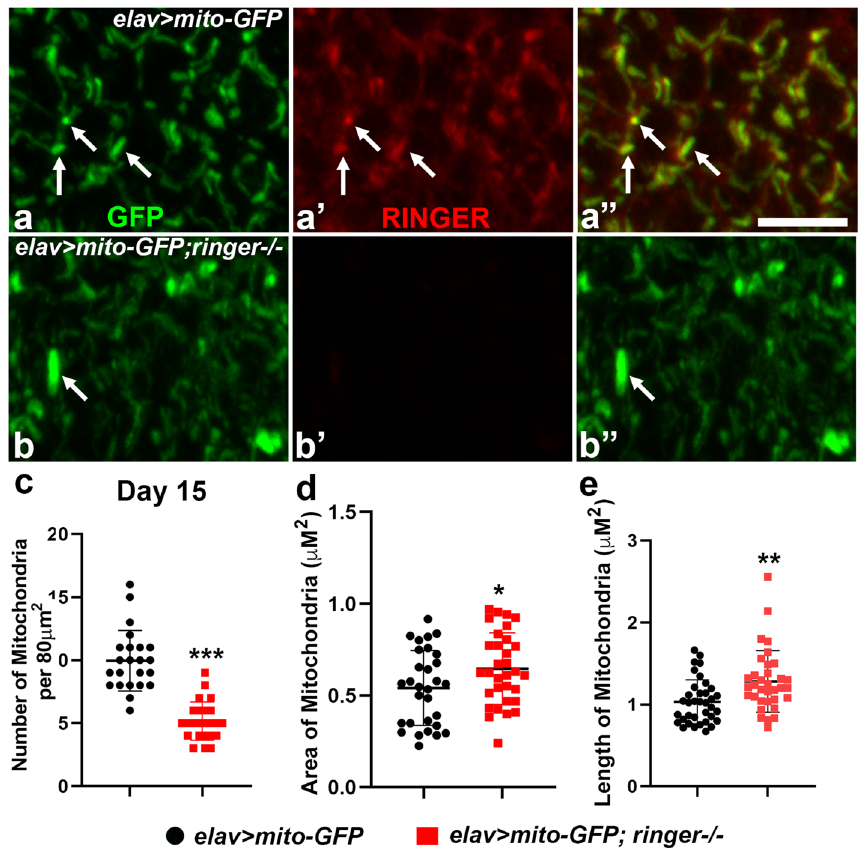
Figure 4. Ringer localizes to mitochondria and loss of Ringer leads to mitochondrial enlargement. ( a - b” ) Confocal images of day 15 adult brains stained with with anti-GFP (green), ( a , a” and b , b” ) and anti-Ringer (red), ( a’ , a” and b’ , b” ) in elav > mito-GFP ( a - a” ) and elav > mito-GFP,ringer −/− ( b - b” ). ( c - e ) Quantification of the number of mitochondria ( c) , area of mitochondria ( d ) and length of mitochondria ( e ) in day 15 flies of elav > mito-GFP (black) and elav > mito-GFP,ringer −/− (red). Scale bar in ( a - b” ) = 5 µm. n ≥ 7 brains for each genotype. Statistics was done using unpaired student’s t test. ( c ) *** p < 0.0001, ( d ) * p = 0.038, ( e ) ** p =